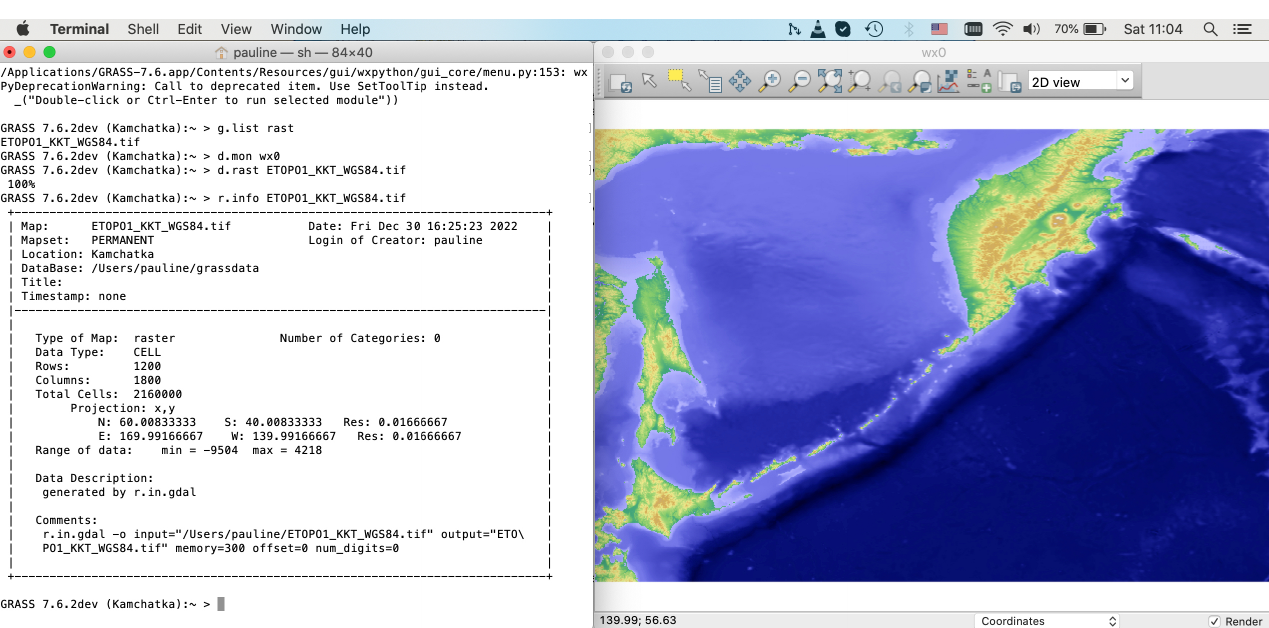
Figure 2. Subset of the study area (Kuril–Kamchatka region), in the Cartesian XY coordinates (metadata: left ) visualized on a display (GRASS GIS GUI: right ). Source: